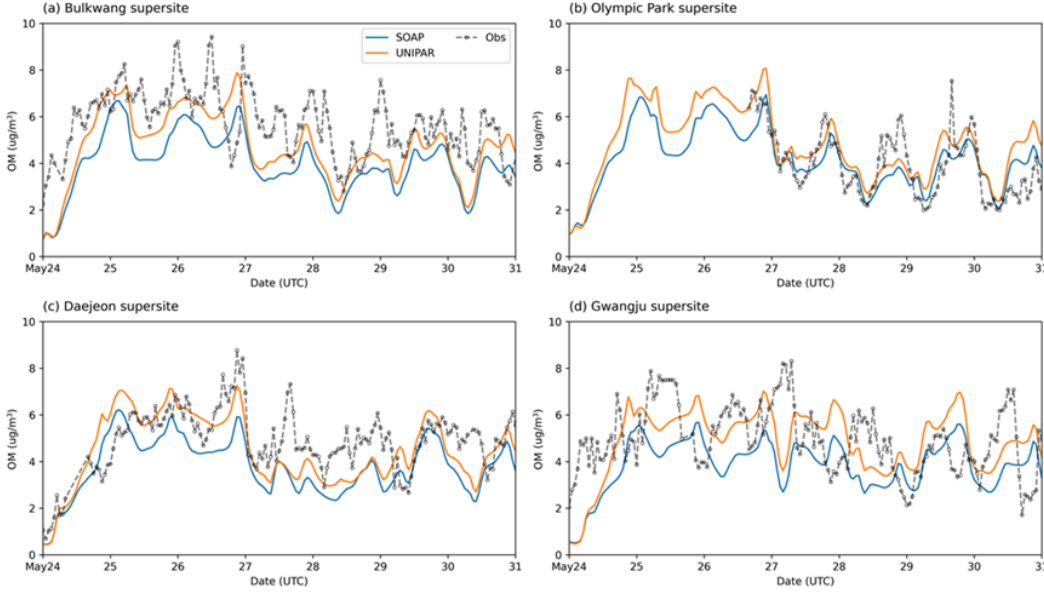
Figure 4. Time profiles of hourly averaged OM concentrations (µgm − 3 ) for the observation data and the CAMx simulation results at the (a) Bulkwang, (b) Olympic Park, (c) Daejeon, and (d) Gwangju